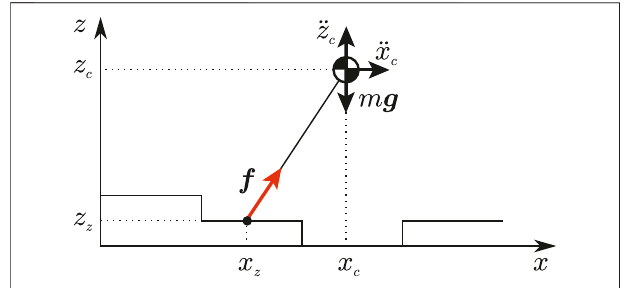
FIGURE2| TheVH-IPmodelinthe x - z plane.Forcesactingontherobot are shown in